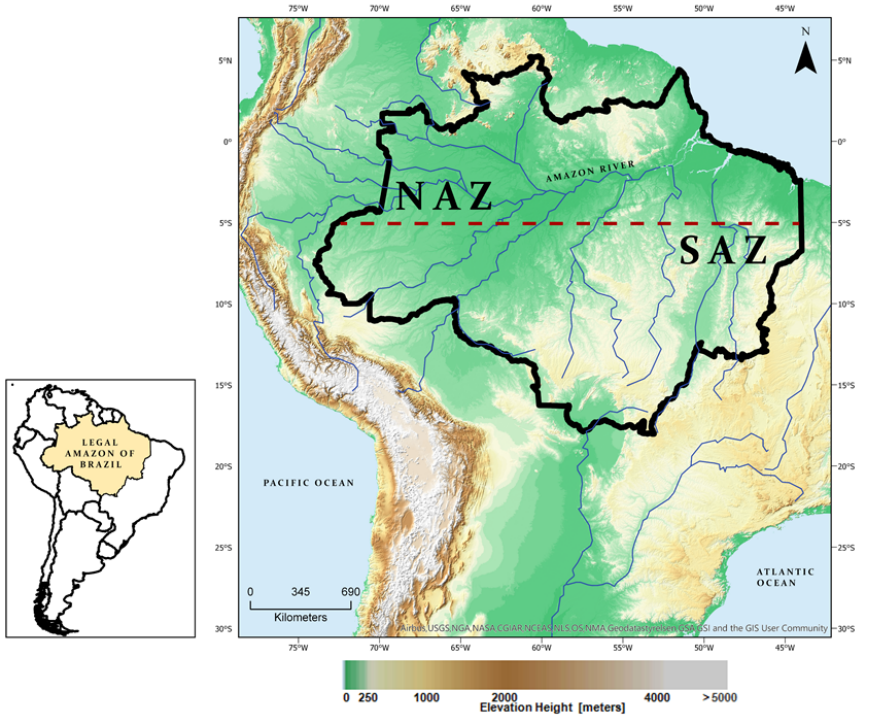
Figure 1. Brazilian Amazon study area with red dotted line indicating a split domain for further analysis. Northern Brazilian Amazon (NAZ) and southern Brazilian Amazon (SAZ).